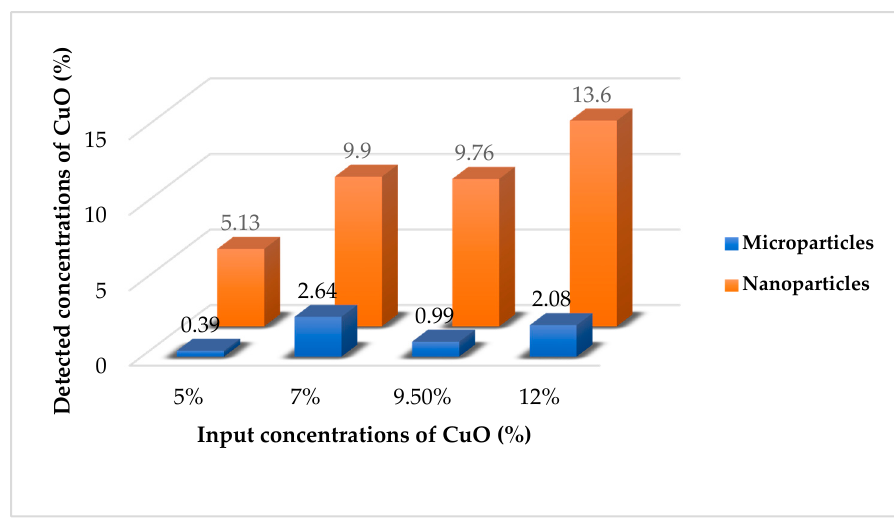
Figure 8. Difference between input and detected concentrations of micro- and nanoparticles of CuO for samples produced from the wire electrode provided by EDX